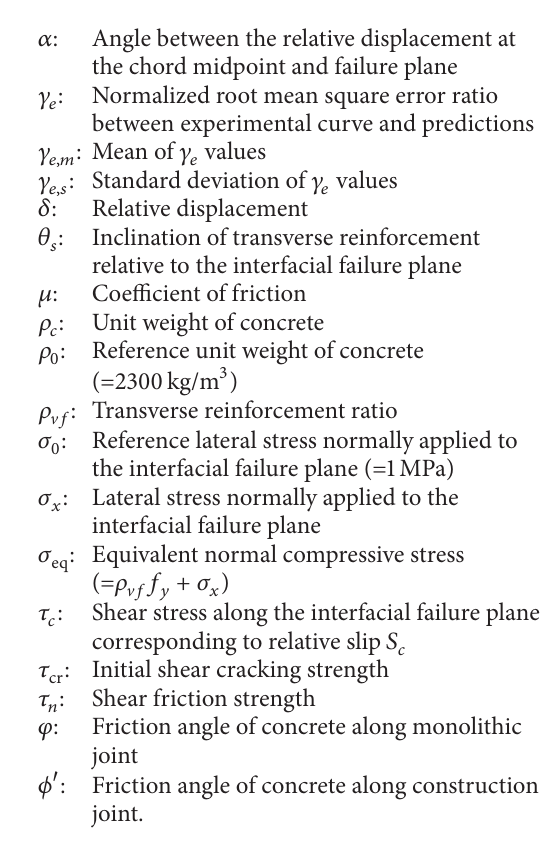
Figure 6: Comparisons of normalized root mean square error ( 𝛾 𝑒 ) against 𝜎 eq : (a) monolithic joints; (b) smooth construction